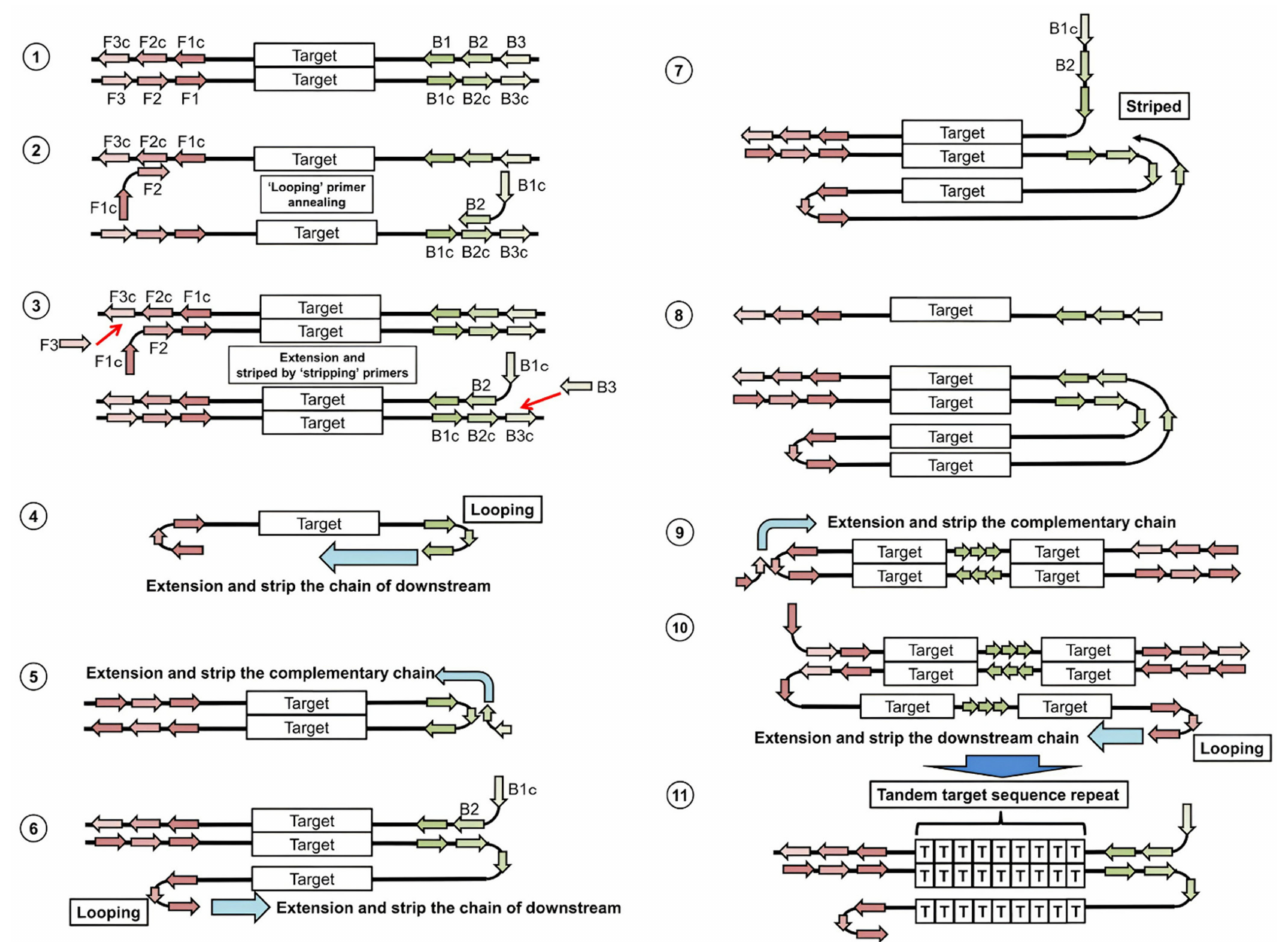
Figure 1. Representation of the LAMP amplification principle in the schematic diagram. Reprinted from Ref.